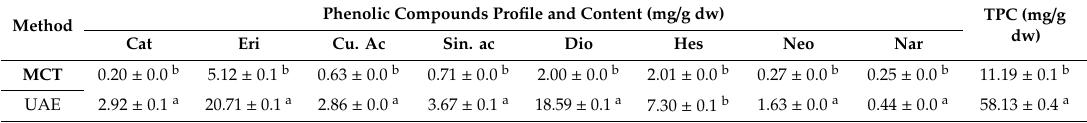
Table 2. Phenolic compounds identification and quantification by ultra-performance liquid chromatography coupled photo diode array (UPLC-PDA) analysis from waste Persian Lemon obtained by UAE and maceration